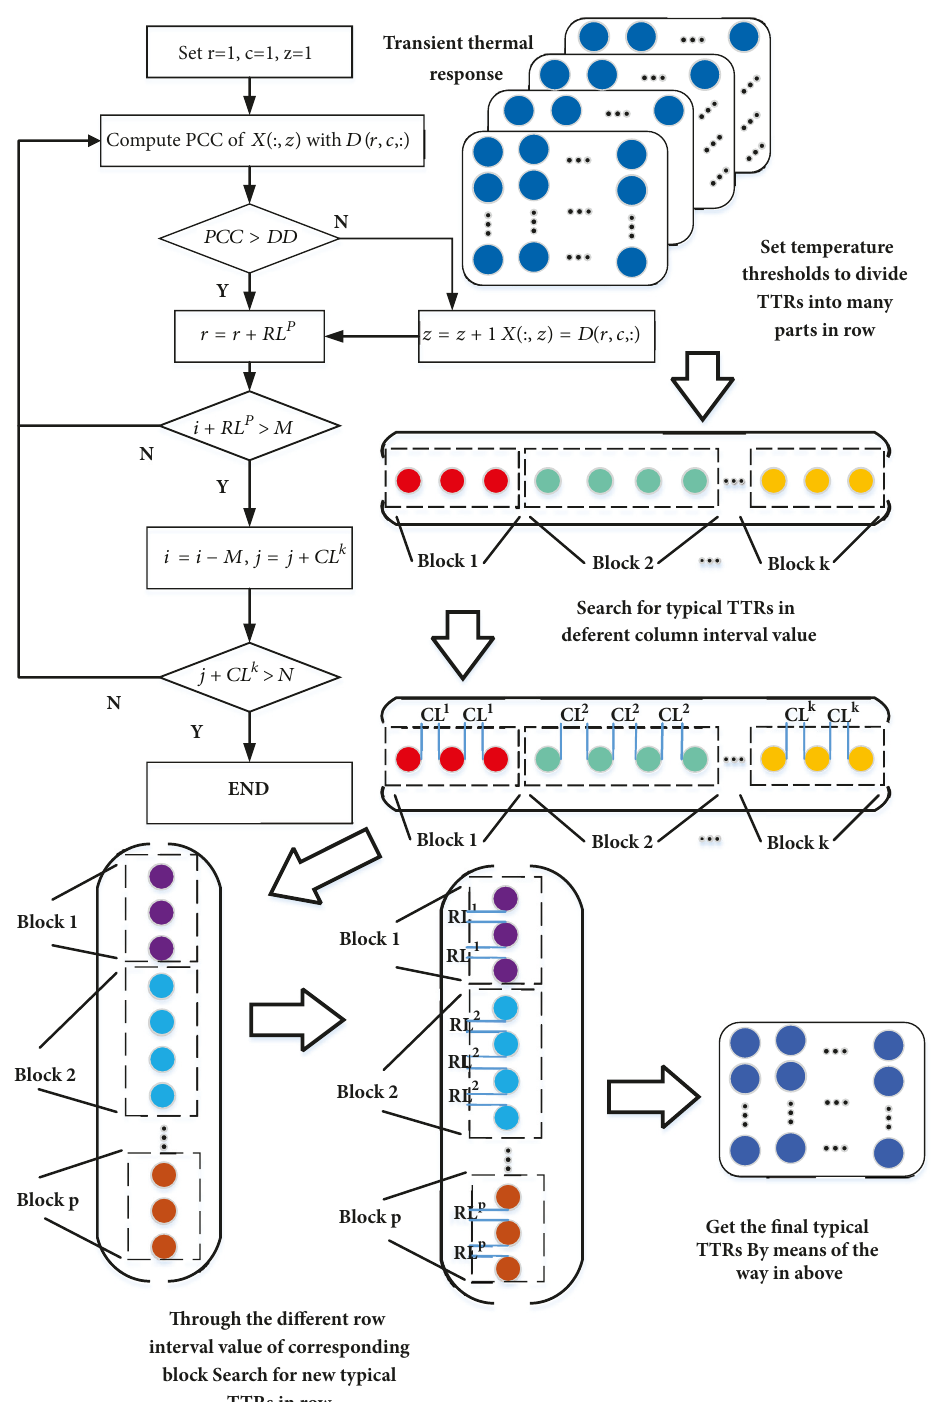
Figure 3: The specific process of Step